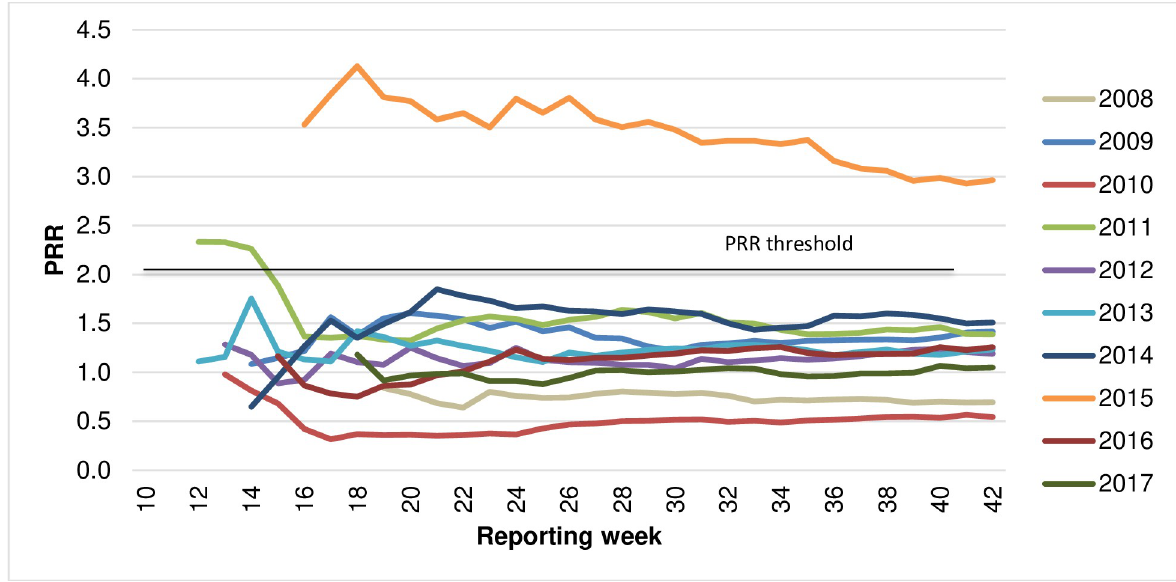
Fig 2. PRR cumulative (individual year) for Influenza vaccines and allergy-related AEFI, by reported year and week, 2008–2017.